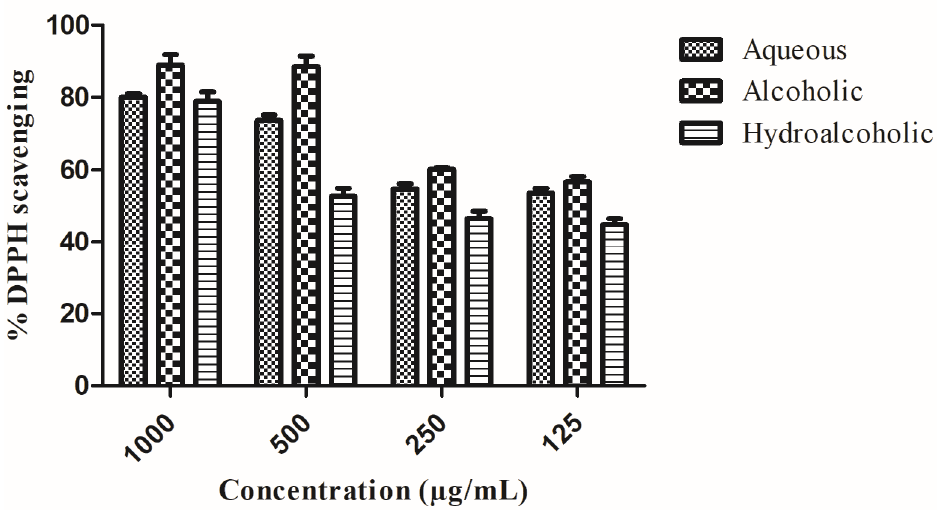
Figure 2. Assessment of free radical scavenging activity using the DPPH assay (% DPPH inhibi-